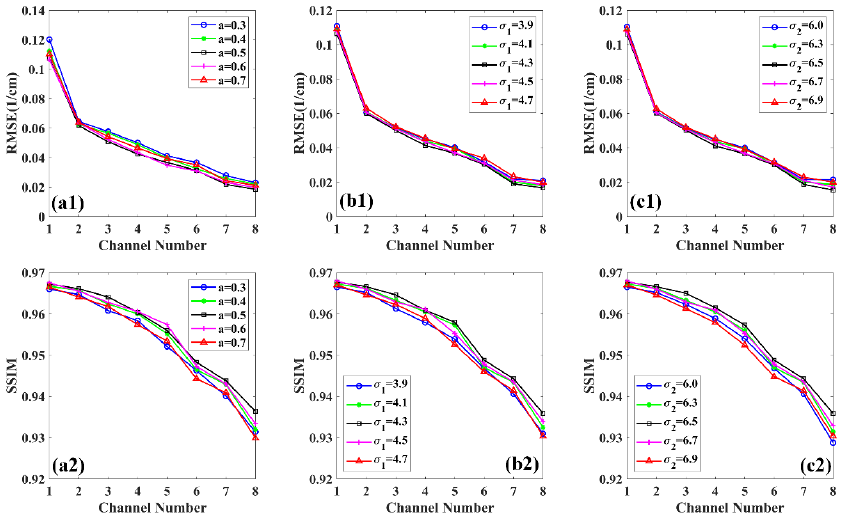
Figure 12. RMSE and SSIM analysis of different parameters: Parameter a ( a ), σ 1 ( b ), σ 2 ( c ).